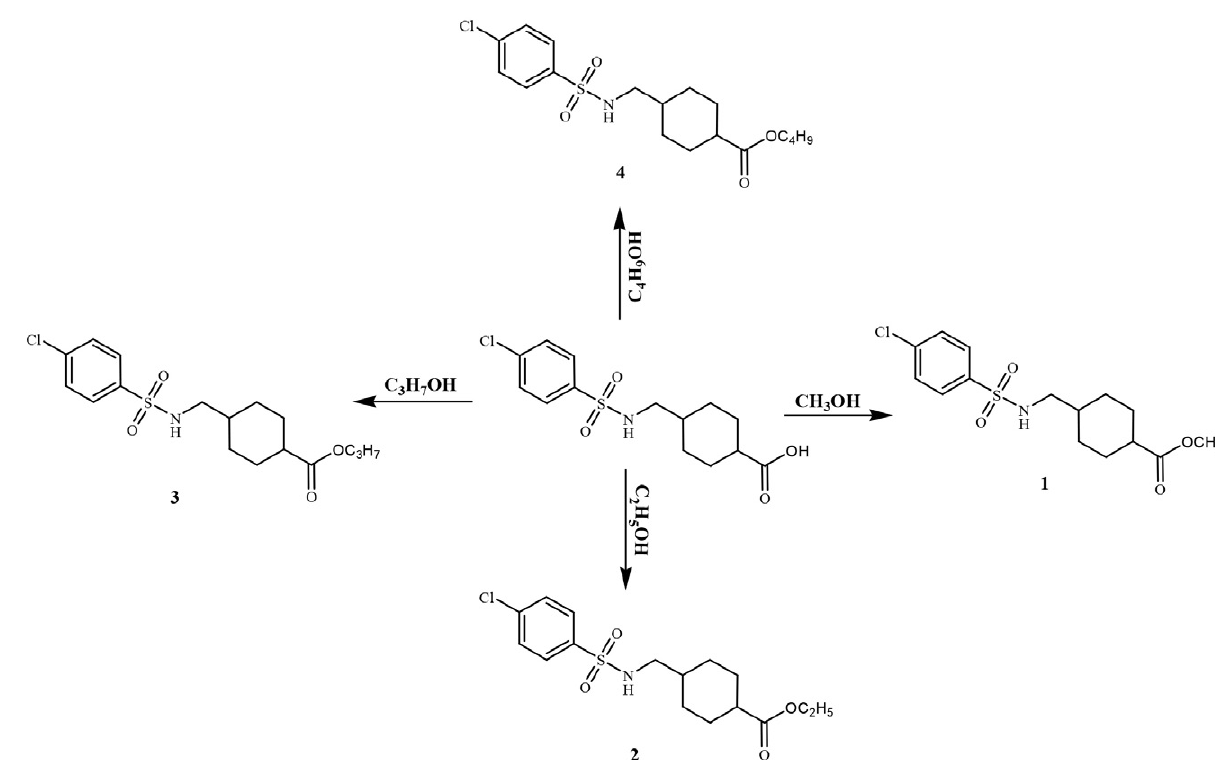
Scheme 1. Synthesis of carboxylate esters of